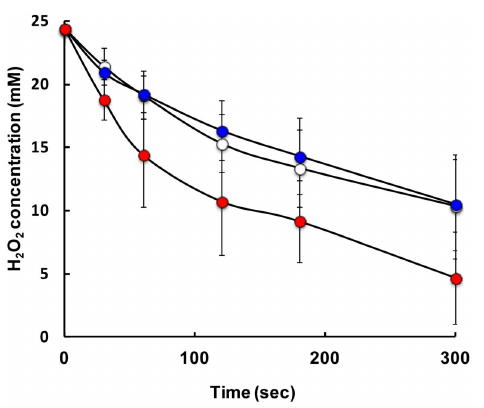
Figure 3. Degradation of hydrogen peroxide in cell suspension of E . oxidotolerans T-2-2 T obtained from 5, 14 and 24 h cultures. Culture periods of 5, 14 and 24 h are indicated by open, blue filled and red filled circles, respectively. The concentration of the original cell suspension was adjusted on the basis of the total catalase activity of the cell